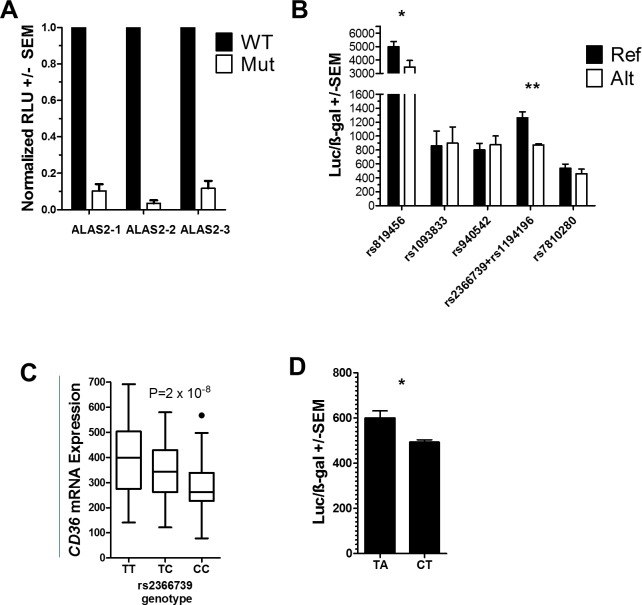
Luciferase assay of MPRA-identified variants.(A) Relative luciferase activity of reporter vectors containing control (WT) or mutated (Mut) GATA1 sites. (N = 3) Significance by one-sample T-test (B) Luciferase activity normalized to β-gal activity of MPRA-functional CD36 variants in K562 cells. Reference (Ref) and Alternate (Alt) alleles for each variant is indicated. (C) Platelet eQTL analysis indicated that platelet CD36 mRNA levels are associated with rs2366739 genotype (P = 2 x 10−8). Line = mean expression, Box = 25th to 75 interquartile range (IQR), Whiskers = 1.5 x IQR. (D) Luciferase activity normalized to β-gal activity of reporter vectors containing the rs2366739-rs1194196 locus transfected into Meg-01 cells. (B,D) N = 3 to 5 Significance by two-sample T-test. * <0.05, ** < 0.01.